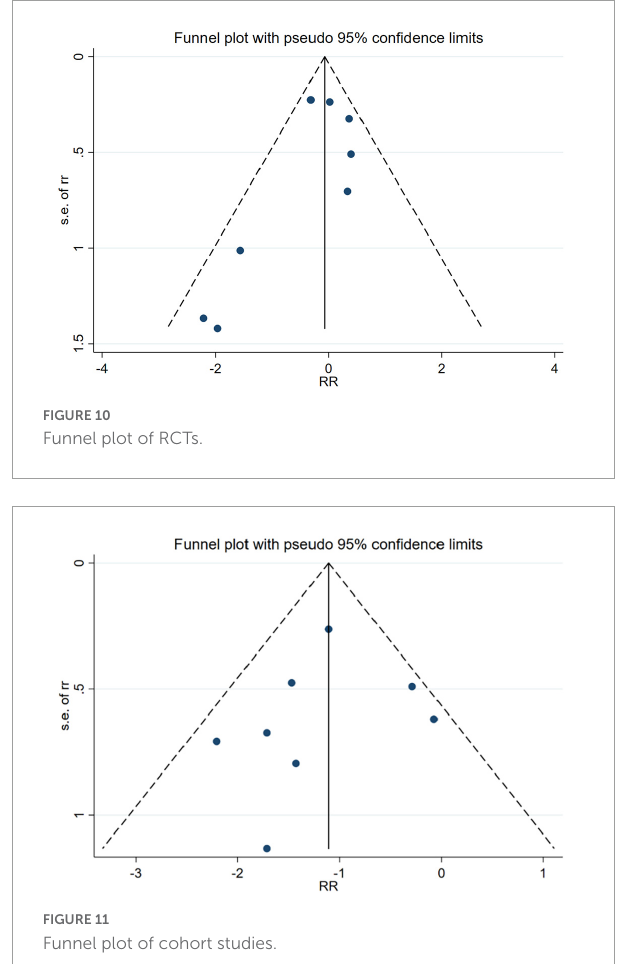
FIGURE11 Funnel plot of cohort